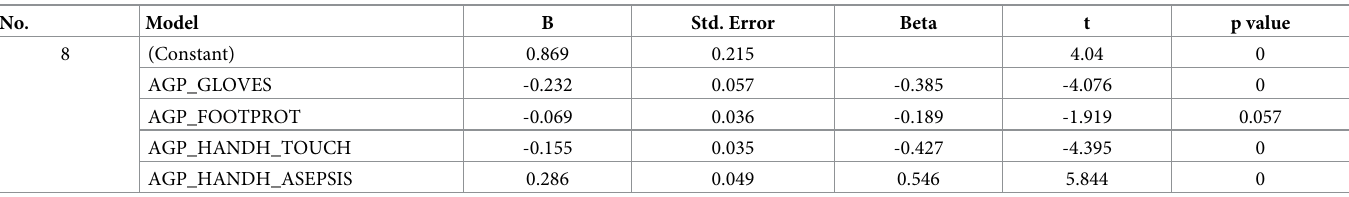
Table 7. Coefficients for the final model (Model no. 8). Testing hypothesis